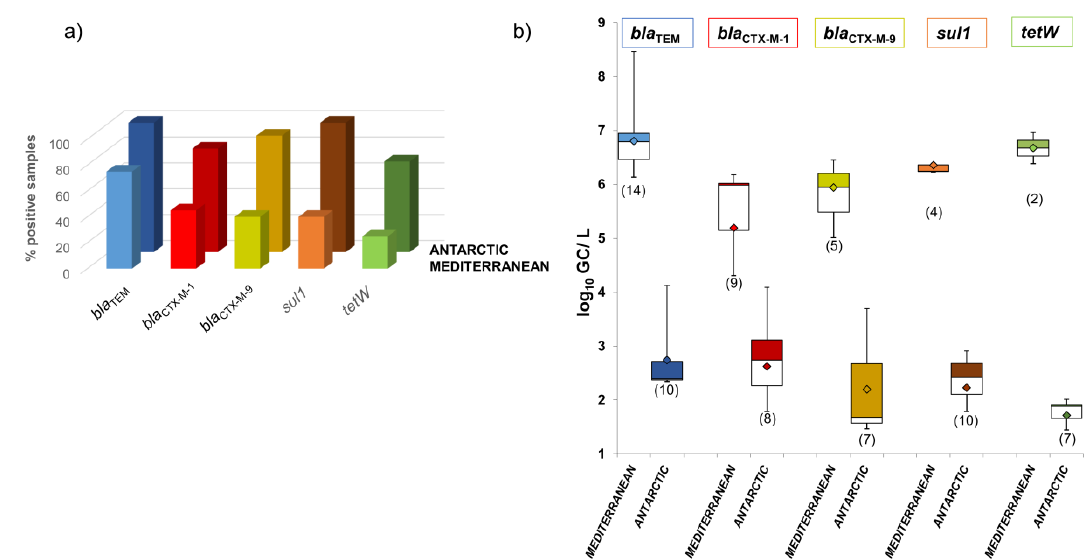
Figure 2. Antibiotic resistance genes (ARGs) in phage particles in Mediterranean and Antarctic seawater samples. ( a ) Percentage of positive samples for each ARG. ( b ) Abundance of each ARG in seawater (log 10 GC/L). Data are represented in boxplots; the diamond represents the average value of the positive samples, the upper squares include samples whose values are within the 75th percentile, and those in the lower white boxes are within the 25th percentile.